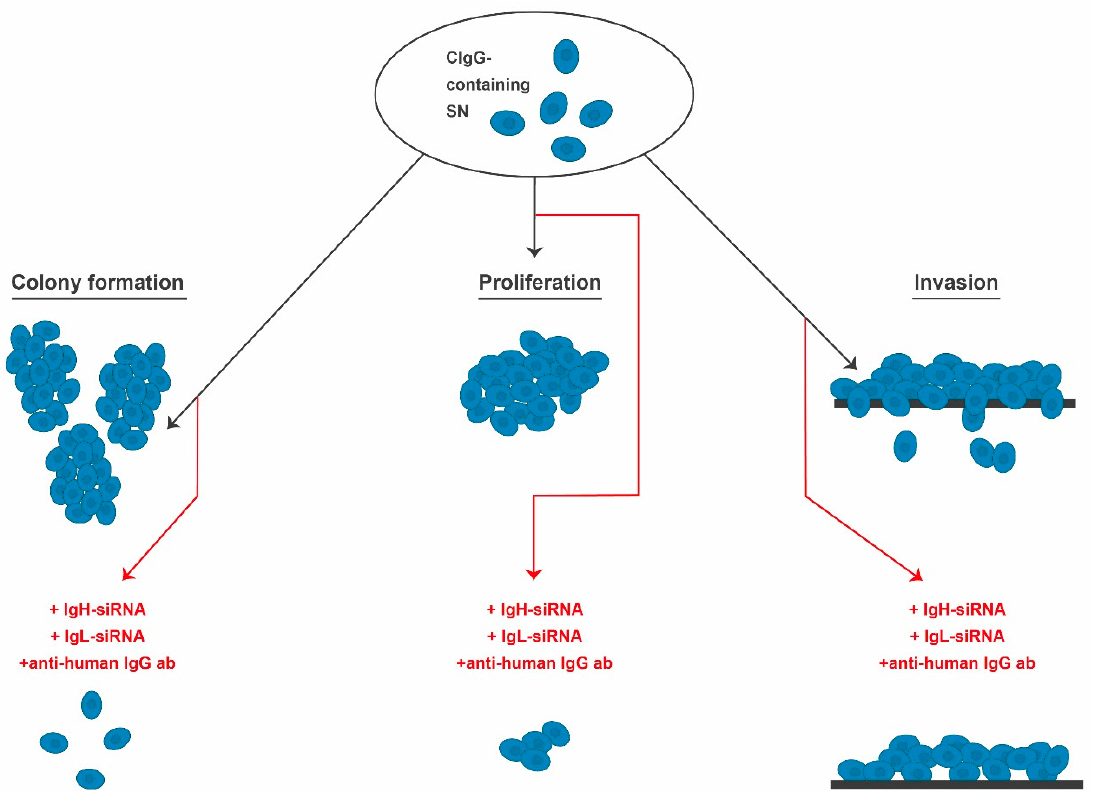
Figure 2. CIgG expression increases the cancer cells’ abilities in terms of colony formation, proliferation, and invasion. A reduction of these properties can be observed when targeting cancer cells with IgH-siRNA, IgL-siRNA, or anti-human IgG antibodies. CIgG: cancer-derived IgG, IgG: immunoglobulin G, ab: antibody, SN: supernatant, IgH: immunoglobulin heavy chain, IgL: immunoglobulin light chain, siRNA: small interfering RNA.